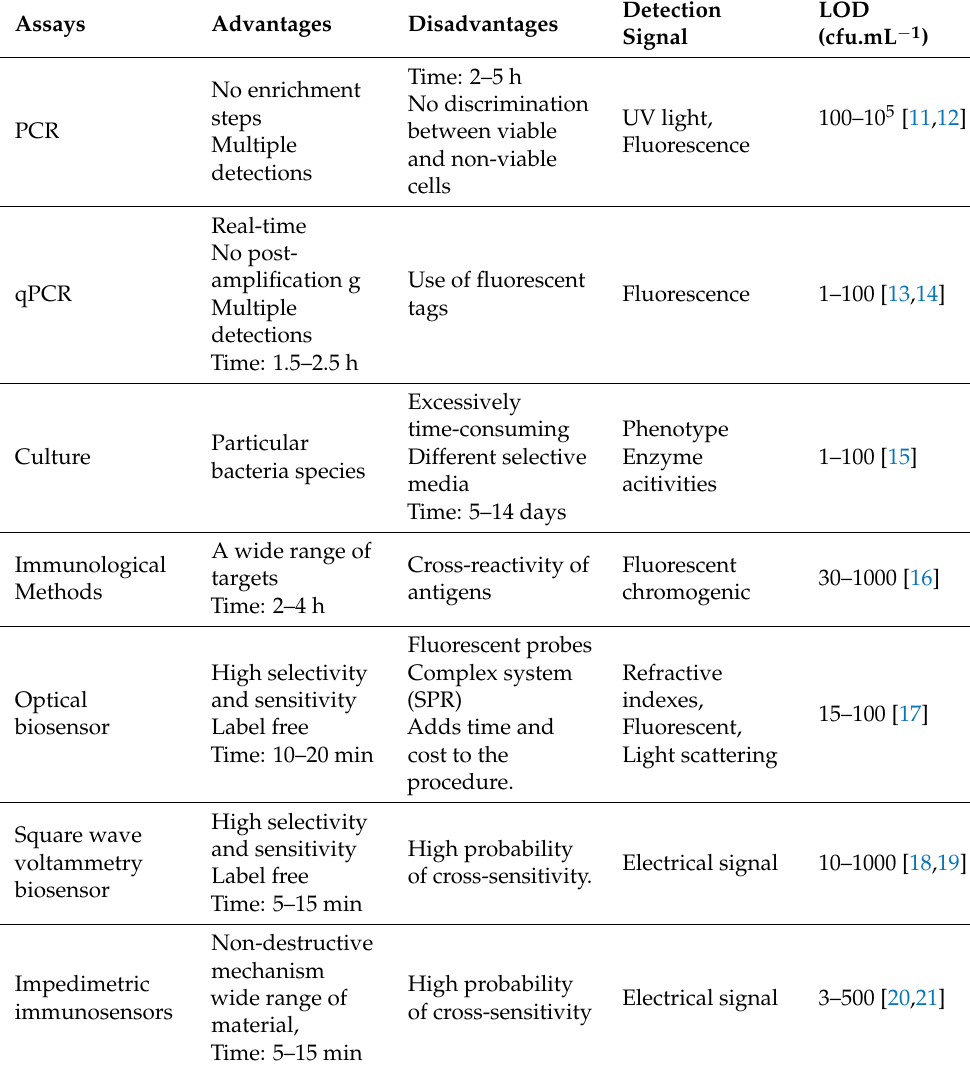
Table 1. Examples of the characteristics of conventional methods and biosensors for whole-cell